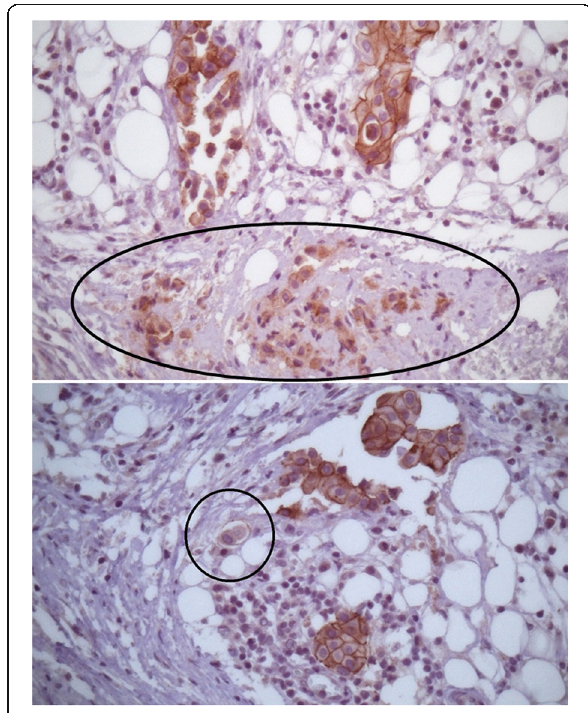
Fig. 7 a and b Immunohistochemistry showing the loss of E- Chaderin expression in the plasmocytoid type of urothelial